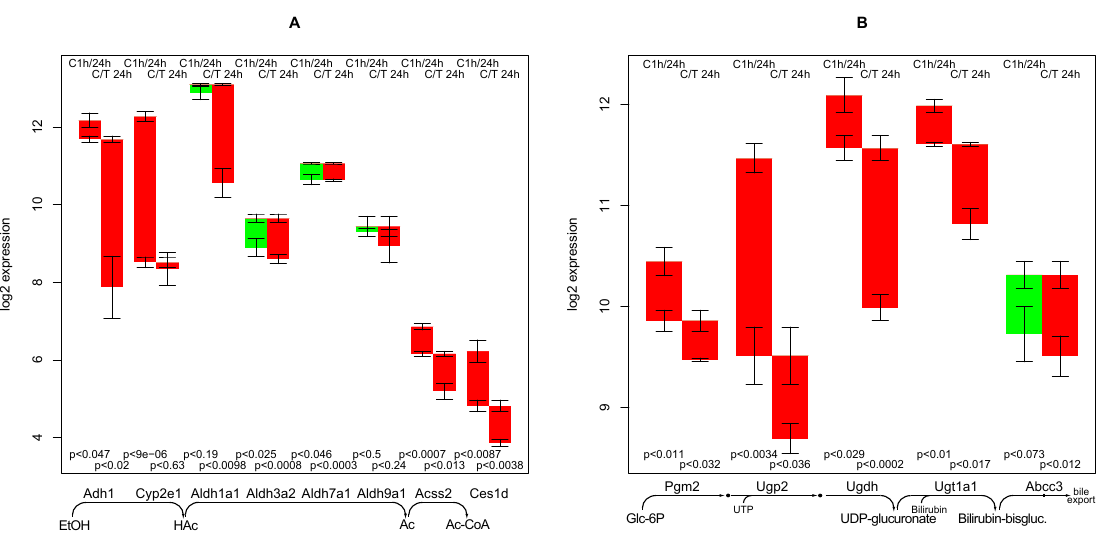
Figure 3. Regulation of genes involved in ethanol degradation ( A ); and bilirubin conjugation ( B ). Among the genes encoding alcohol and aldehyde dehydrogenase only those are selected that show a sufficient expression in hepatocytes and activity on